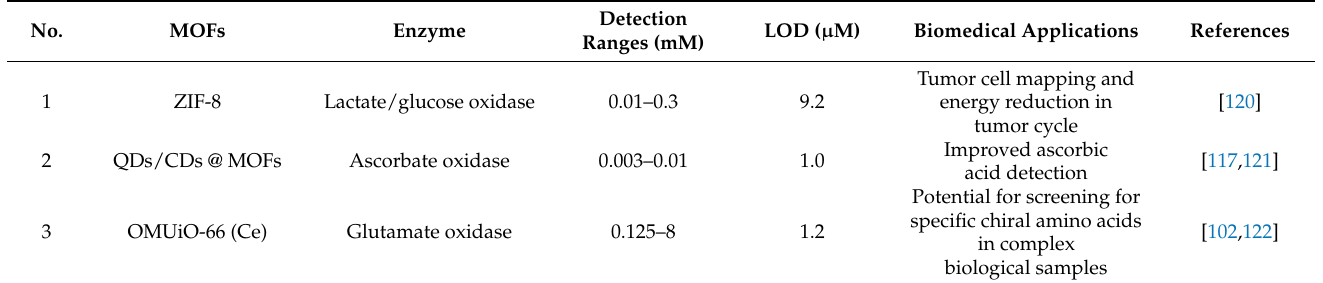
Table 2. Summary of biomedical applications of enzyme–MOF composites reported in the literature in recent years.